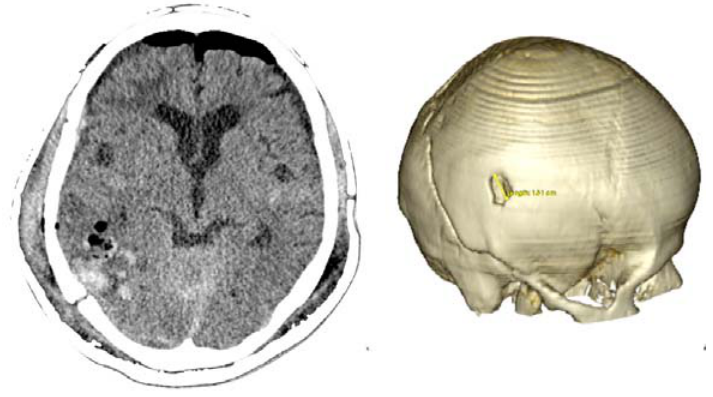
Figure 6. CASE 3. Post-operative results. The patient underwent endoscopic resection of contusional hematoma through a burr-hole. Superficial hematoma like this can be ressected without the aid of the